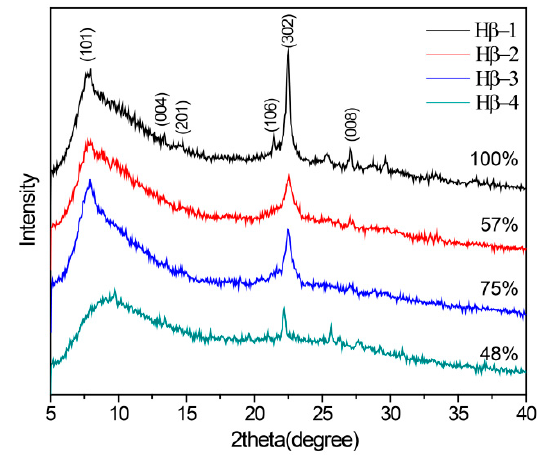
Figure 1. X-ray powder diffraction (XRD) patterns H β -1 (black), H β -2 (red), H β -3 (blue) and H β -4 (green).